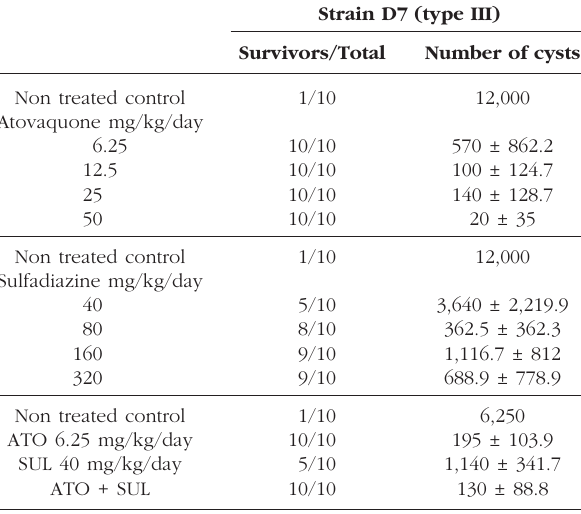
Table IV. – Survival and number of brain cysts in mice infected with D7 strain of T. gondii and treated with different doses of atovaquone (ATO), sulfadiazine (SUL) or drug association (ATO +